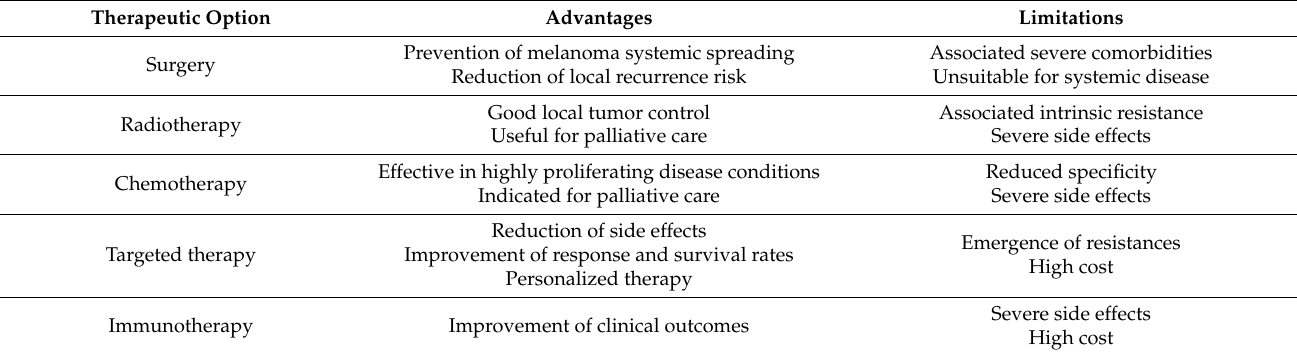
Table 1. Main advantages and limitations of the currently available therapeutic options for melanoma. Therapeutic